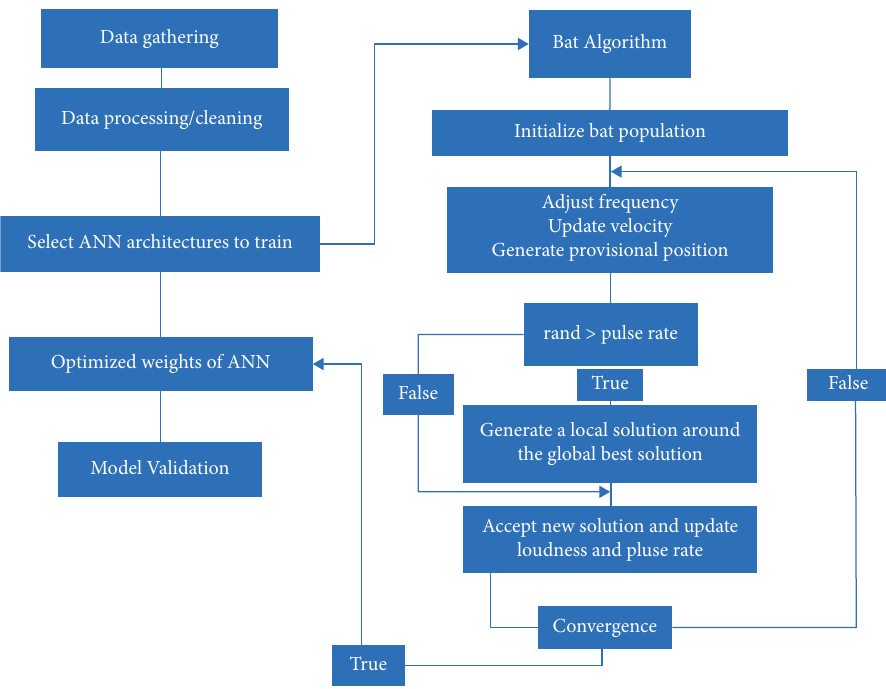
Figure 2: Outline of the paper.